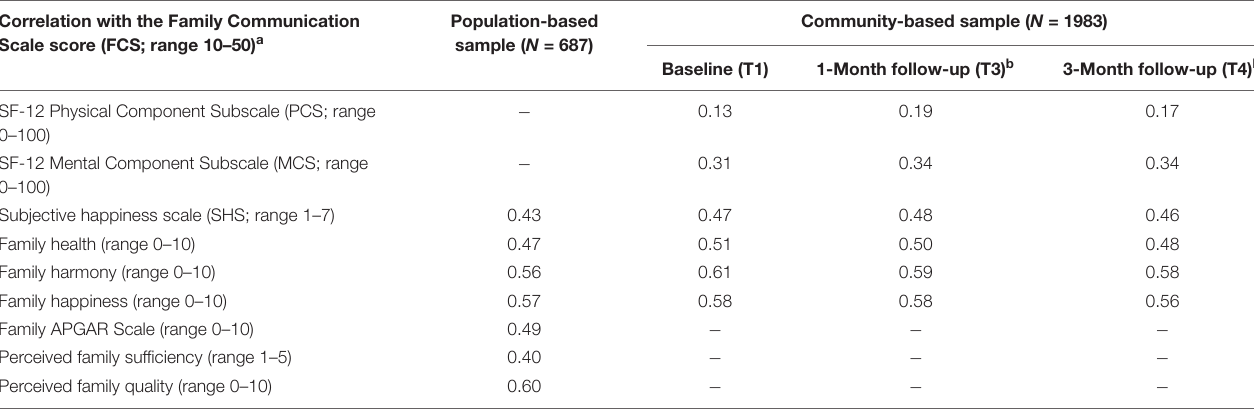
TABLE 4 | Correlations of the Family Communication Scale score with scores of 12-item Short Form Health Survey Version 2, Subjective Happiness Scale, family health, family harmony, family happiness, family APGAR scale, and perceived family communication quality and sufficiency in the population-based sample and community-based